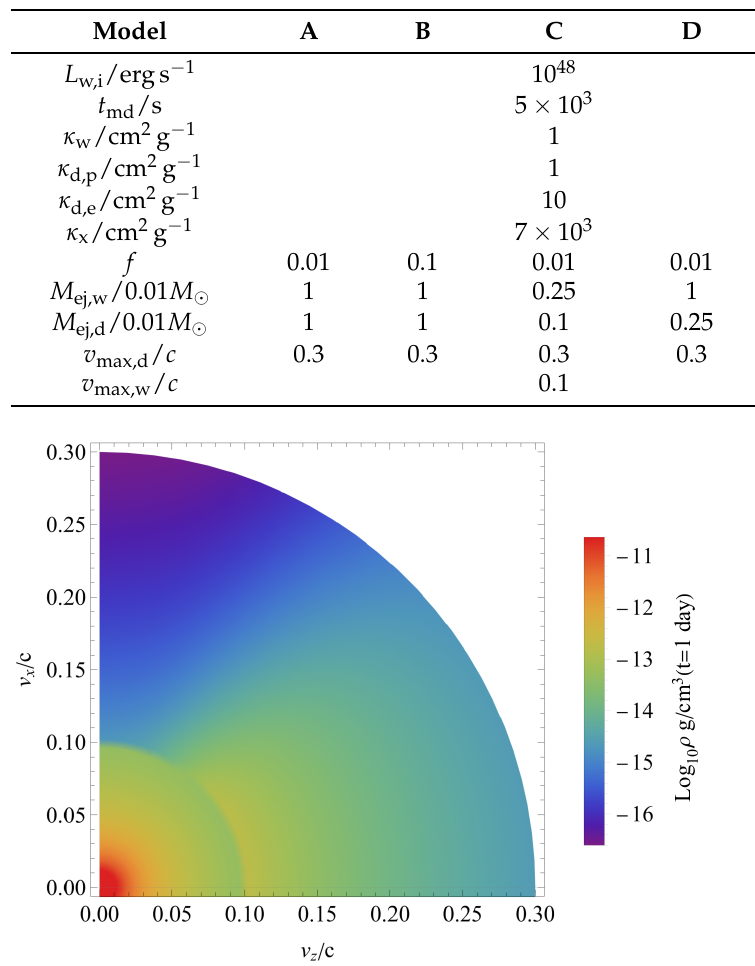
Figure 1. The density profile employed in our